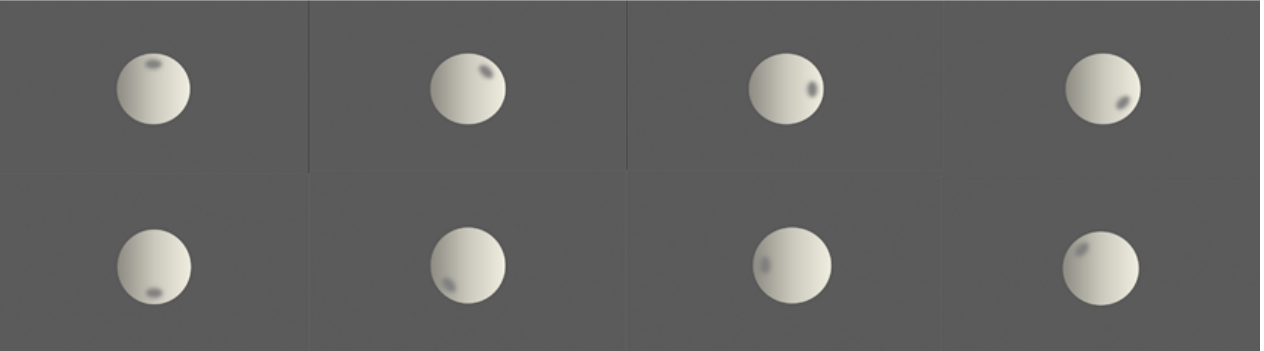
Figure 1. Three-dimensional table tennis ball pictures including hitting locations illustrating stimuli were used in the experiment. The fourth picture of the top and the second picture of the bottom were consistently estimated as possible side-backspin serves by two table tennis coaches and athletes.